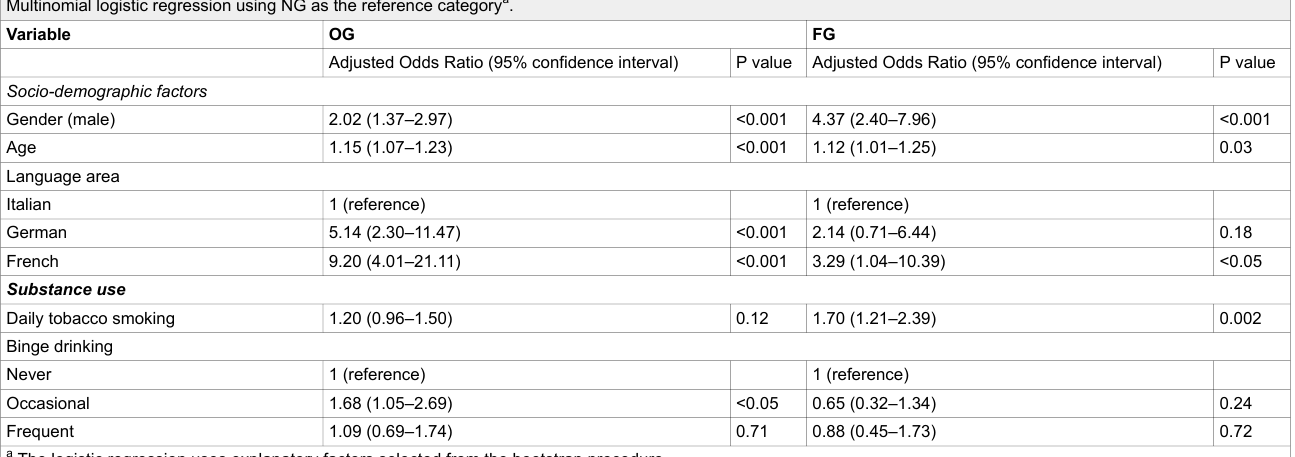
Table 2 Multinomial logistic regression using NG as the reference category a . Variable